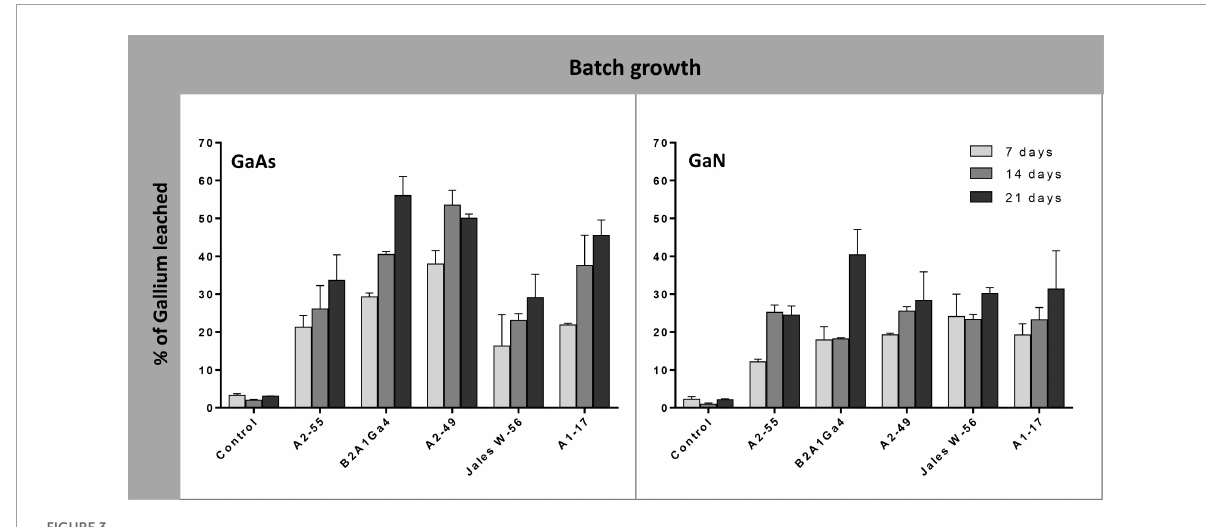
FIGURE3 Gallium leaching from GaAs and GaN in batch growth of Arthrobacter silviterrae A2-55, Rhodanobacter sp. B2A1Ga4, Sphingomonas sp. A2-49, Undibacterium sp. Jales W-56, and Rugamonas sp. A1-17, with mR2Ab medium, pH = 6.0. Ga in leaching medium was determined at day 7, 14 and 21 of the experiments. Data are the mean values ( ± standard deviations) obtained from two or three independent